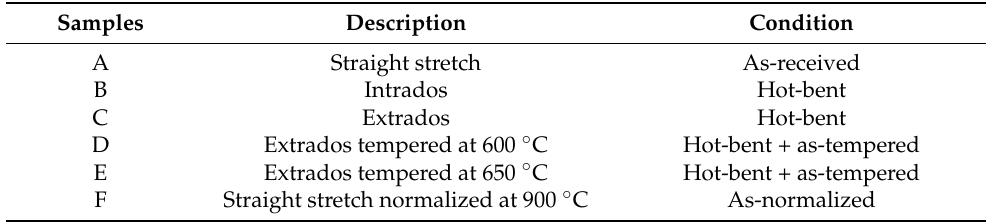
Table 2. Identification of the samples obtained using different processing conditions. Samples Description Condition Straight